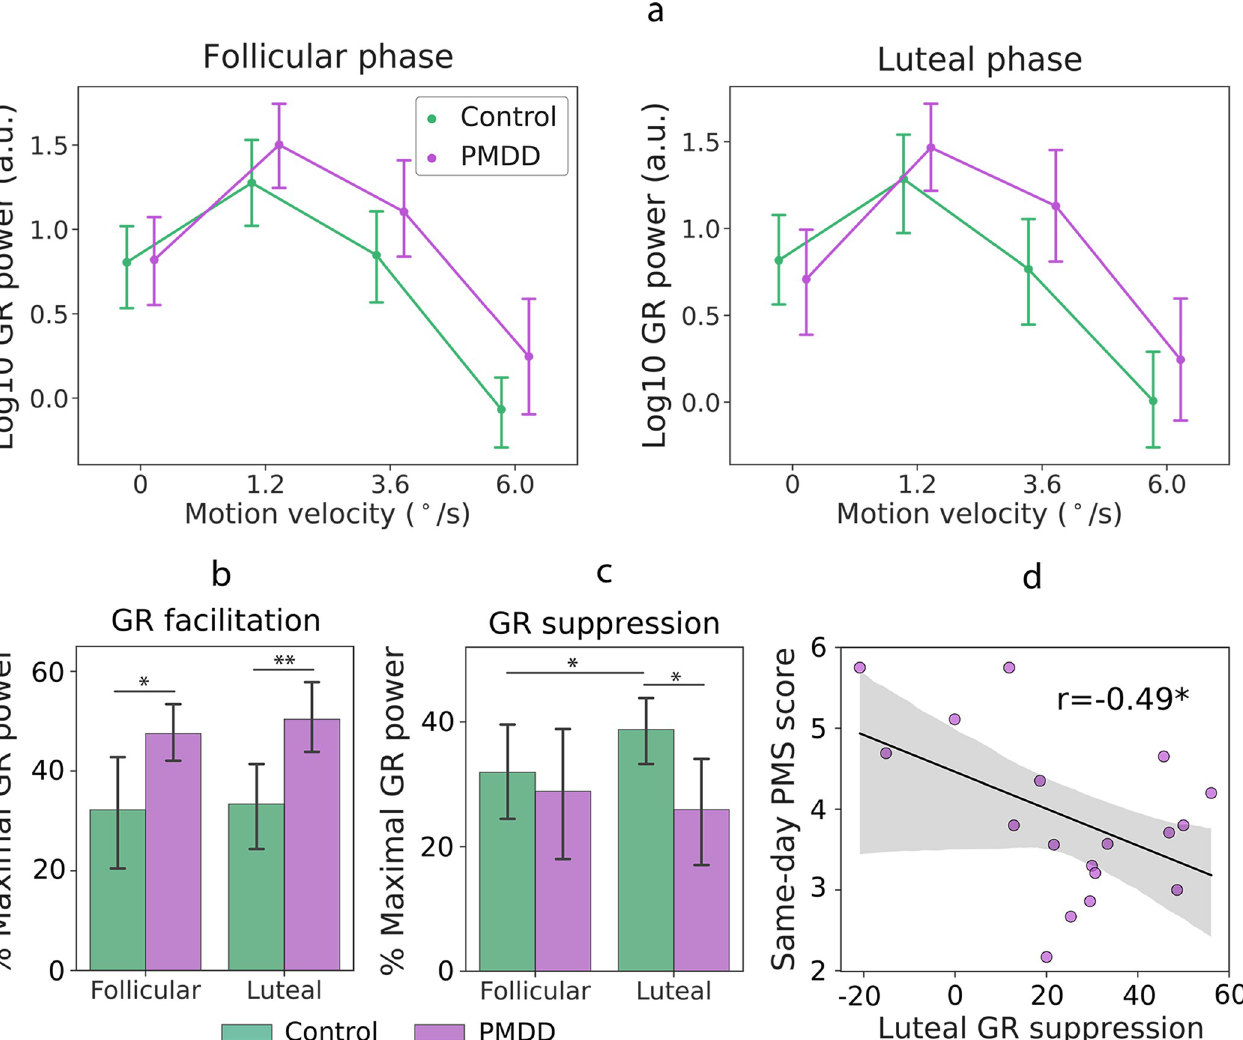
Fig 6. Group differences in gamma response (GR) power. (a) Log10-transformed GR power modulation in four velocity conditions (‘static’: 0˚/s, ‘slow’: 1.2˚/ s, ‘medium’: 3.6˚/s, ‘fast’: 6.0˚/s) in the follicular (left panel) and luteal (right panel) phases of the menstrual cycle. (b) Group differences in velocity-related GR power facilitation from the ‘static’ to the ‘slow’ velocity condition, estimated in percent of the GR power in the ‘slow’ condition, which induced maximal GR at the group level: (1—GR Power Static /GR Power Slow ) � 100%. (c) Group differences in velocity-related GR power suppression from the ‘slow’ to the ‘medium’ velocity condition, estimated in percent of the GR power in the ‘slow’ condition: (1—GR Power Medium /GR Power Slow ) � 100%. (d) Correlation between luteal GR power suppression and premenstrual symptom (PMS) severity measured on the same day in women with PMDD. Error bars and shaded areas represent 95% confidence intervals.